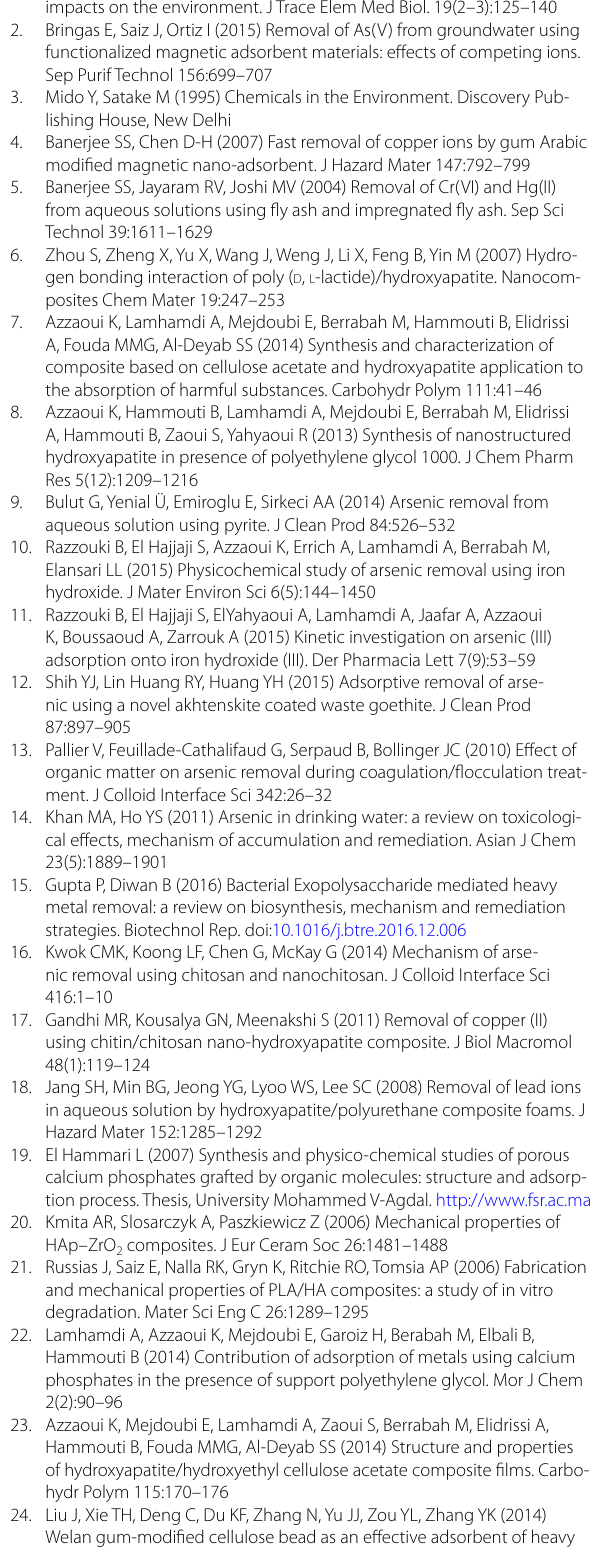
Table 2 Diameter of inhibition (mm) of the prepared com- posites tested on three bacteria and one